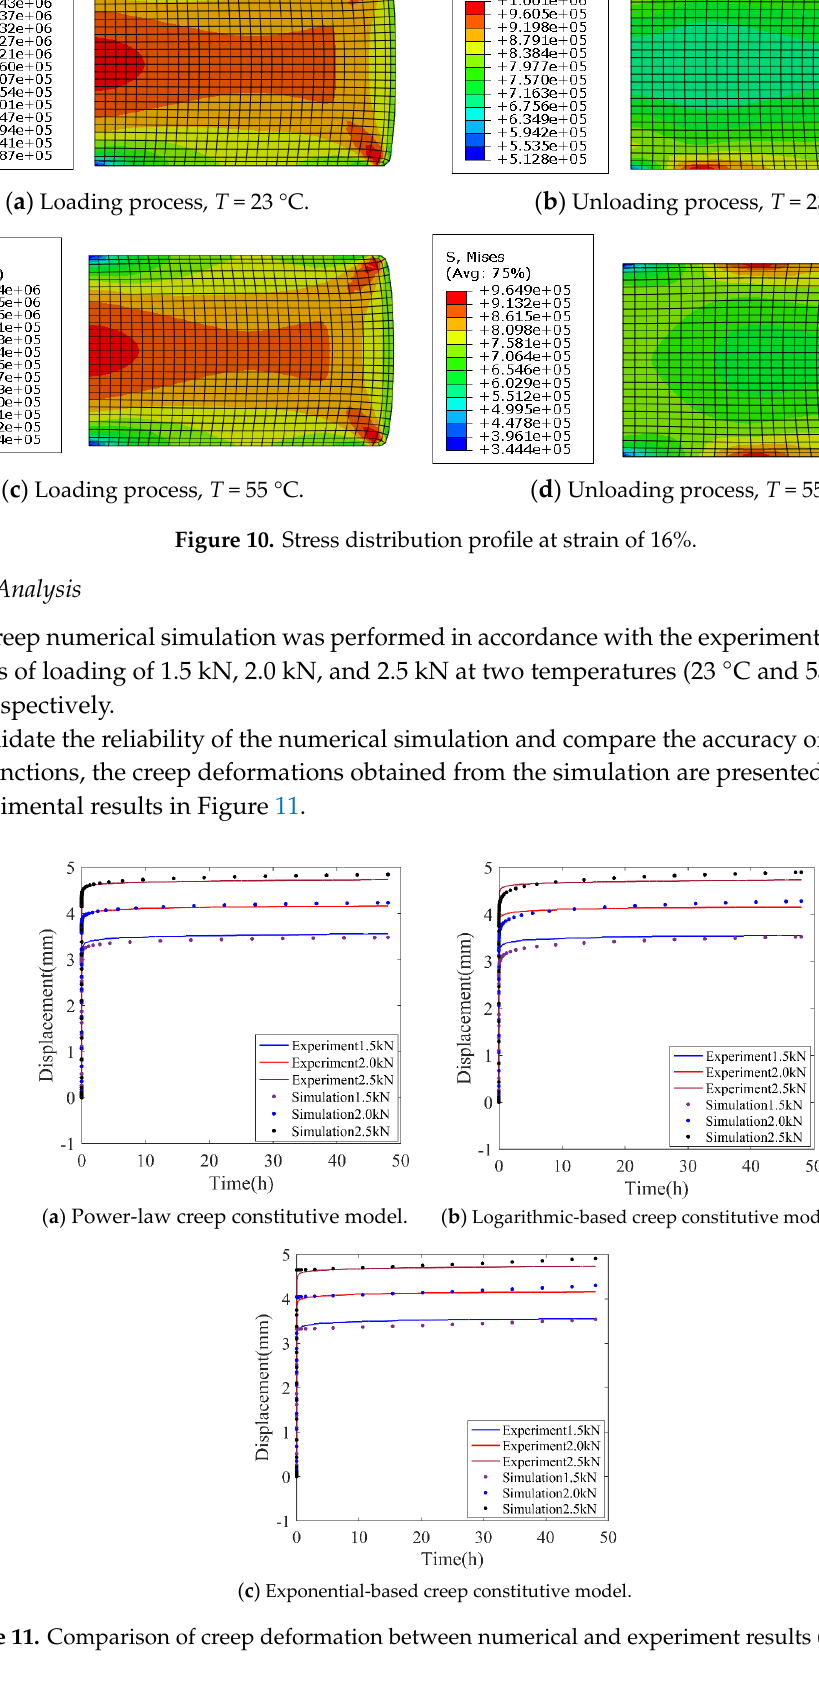
Figure 10. Stress distribution profile at strain of 16%.